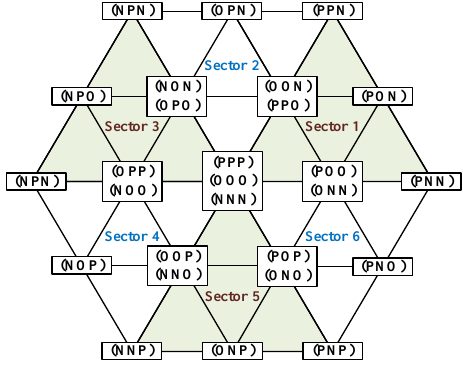
Figure 3. Vector diagram of three-level NPC inverter.